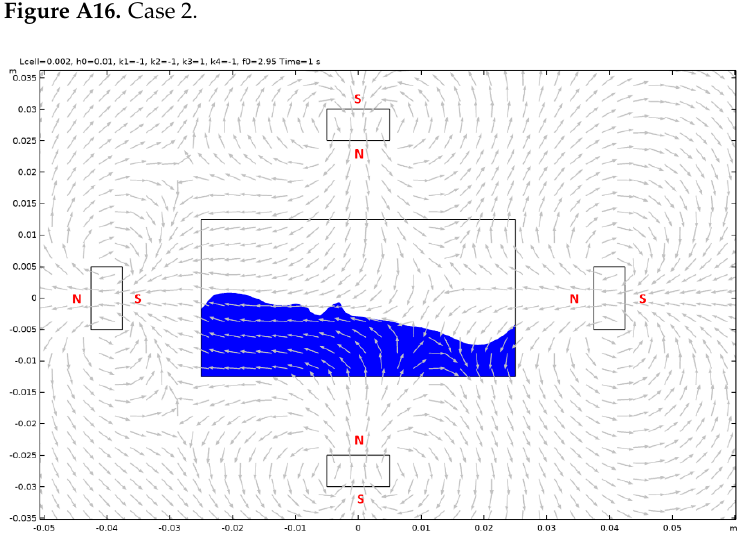
Figure A16. Case 2.